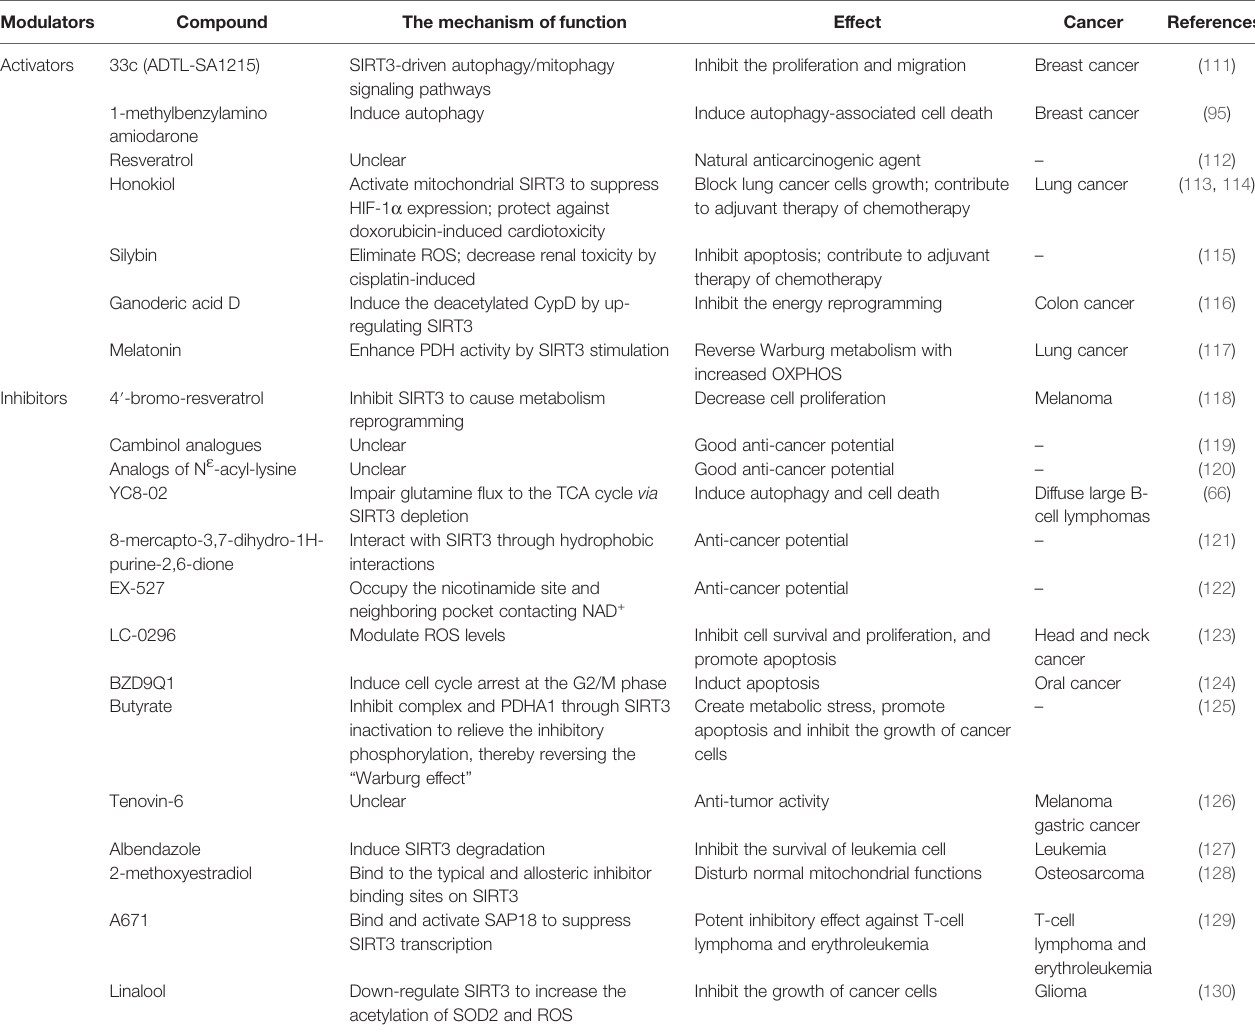
TABLE 4 | Modulators targeting SIRT3 protein in